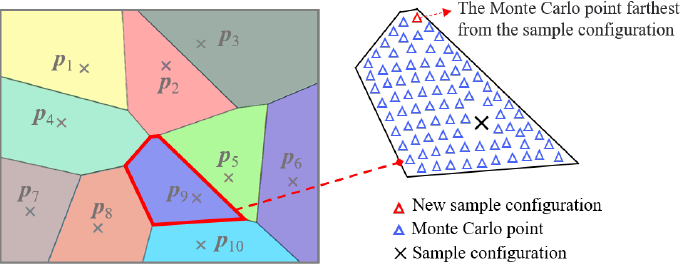
Figure 1. Voronoi diagram in two ‐ dimensional space and Voronoi element by Monte Carlo point description.